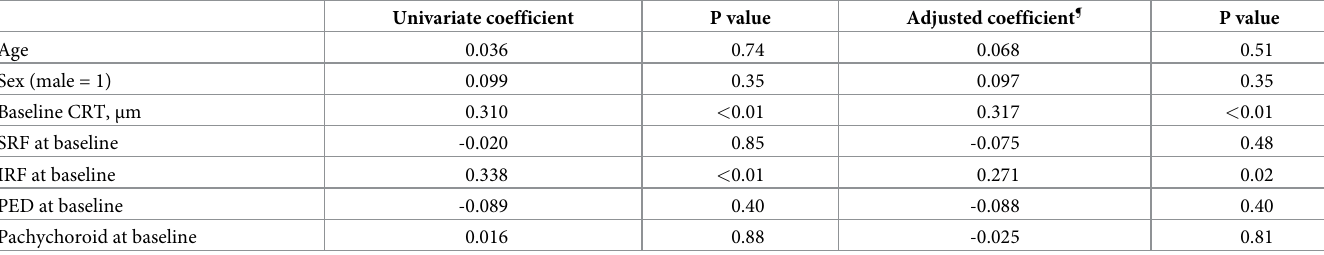
Table 2. Regression analysis of factors associated with baseline